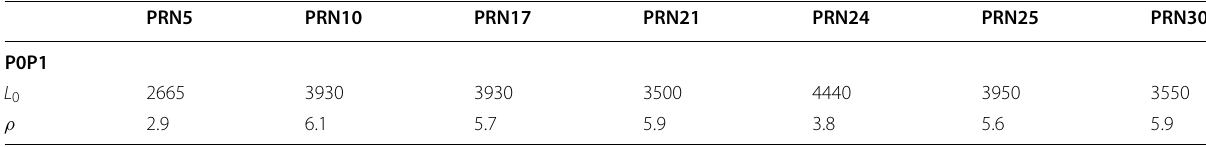
Ionospheric-free linear combination L 0 and ρ are expressed in m. All values given for the outer scale length are approximated to the nearest 5